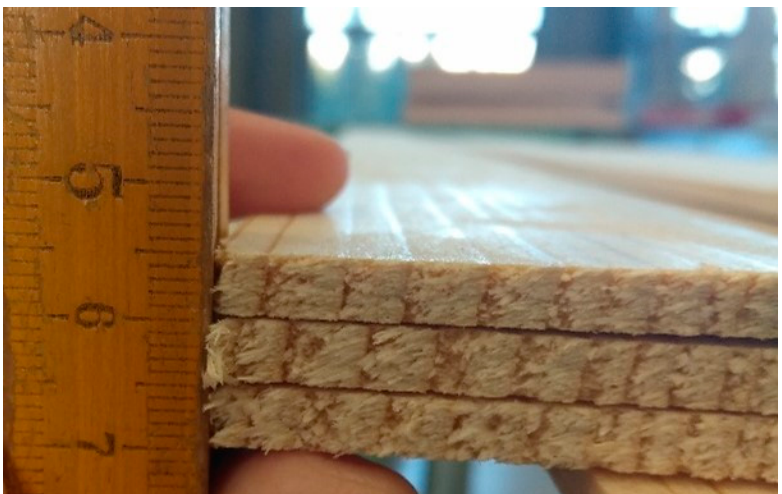
Figure 1. Wood lamellae for specimens.